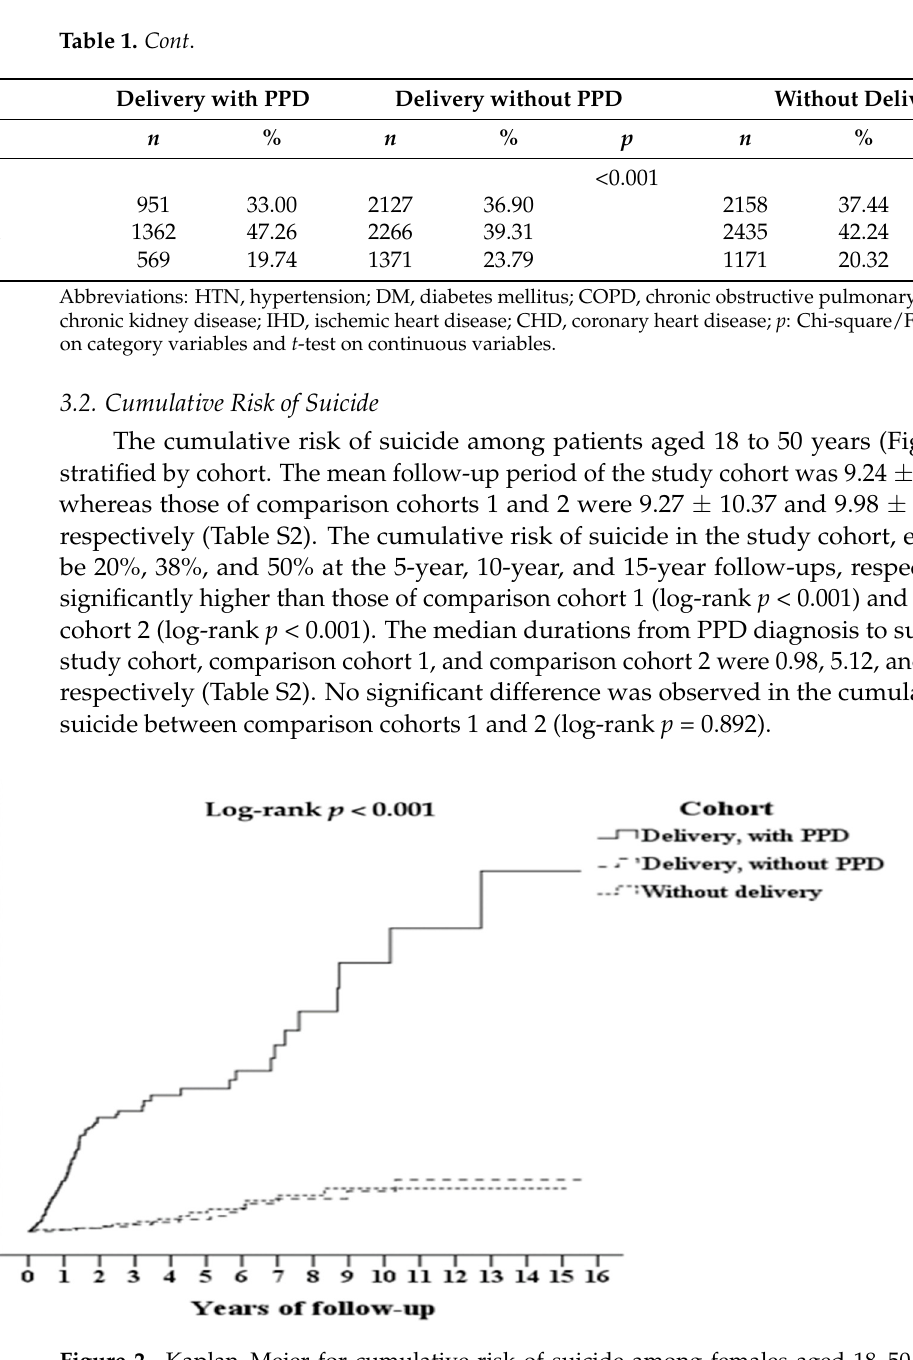
Figure 2. Kaplan–Meier for cumulative risk of suicide among females aged 18–50 stratified by different cohorts with log-rank test. Delivery with PPD vs. delivery without PPD: Log-rank p < 0.001. Delivery with PPD vs. without delivery: Log-rank p < 0.001. Delivery without PPD vs. without delivery: Log-rank p = 0.892. Abbreviation: PPD, postpartum depression.